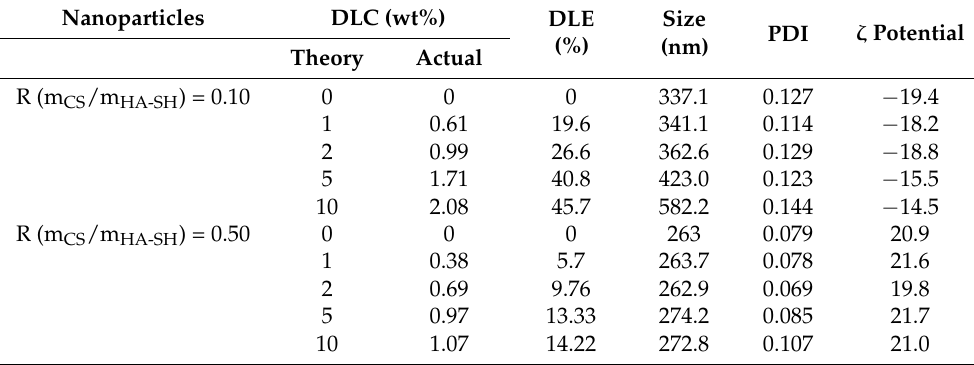
Table 1. Characteristics of DOX-loaded HA – SH/CS nanoparticles.